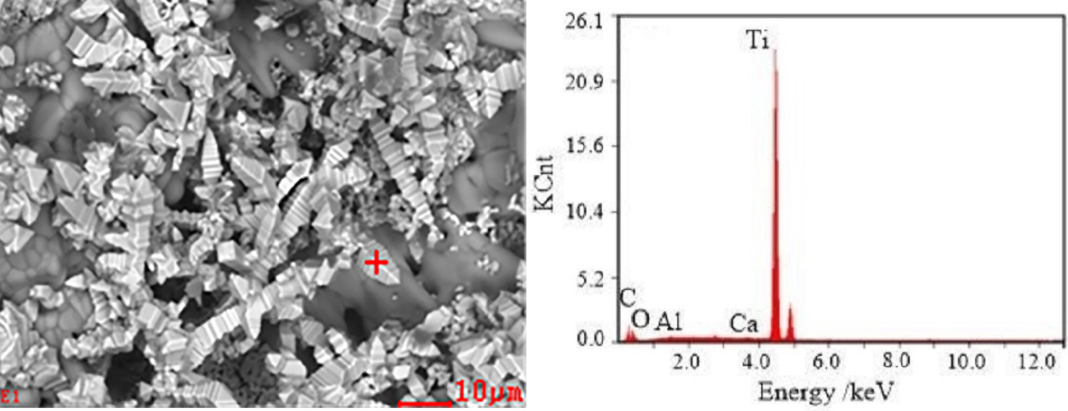
Figure 9. Energy-dispersive X-ray spectroscopy (EDS) analysis after corrosion of TiB 2 coating surface.